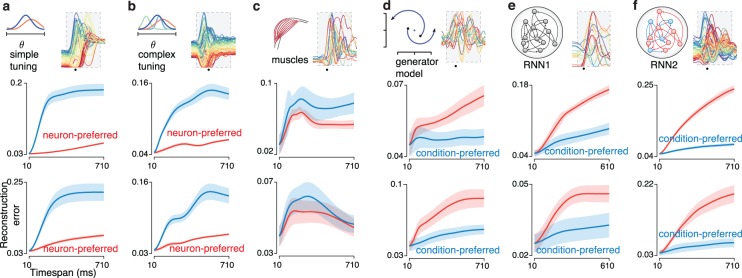
Preferred-mode analysis for non-neural data.Analysis is shown for ten simulated datasets and two muscle populations. Presentation as in Fig 4. (a) Analysis of simulated M1 populations from the simple tuning model. Two simulated populations (top and bottom) were based on recorded kinematic parameters of two animals (J and N), acquired during the same experimental sessions for which the neural populations are analyzed in Fig 4C. (b) As in a, but M1 populations were simulated based on a more complex tuning model. (c) Analysis of populations of muscle responses (monkeys J and N, top and bottom) recorded using the same task/conditions as in Fig 4D. (d) Analysis of two simulated M1 populations from the dynamical ‘generator model’ that was trained to reproduce patterns of muscle activity. The model was trained to produce the patterns of deltoid activity from the muscle populations in panel c. (e) Analysis of two simulated M1 populations from a neural network model trained to produce the patterns of muscle activity shown in panel c. (f) Analysis of two simulated M1 populations from a ‘non-normal’ neural network model.